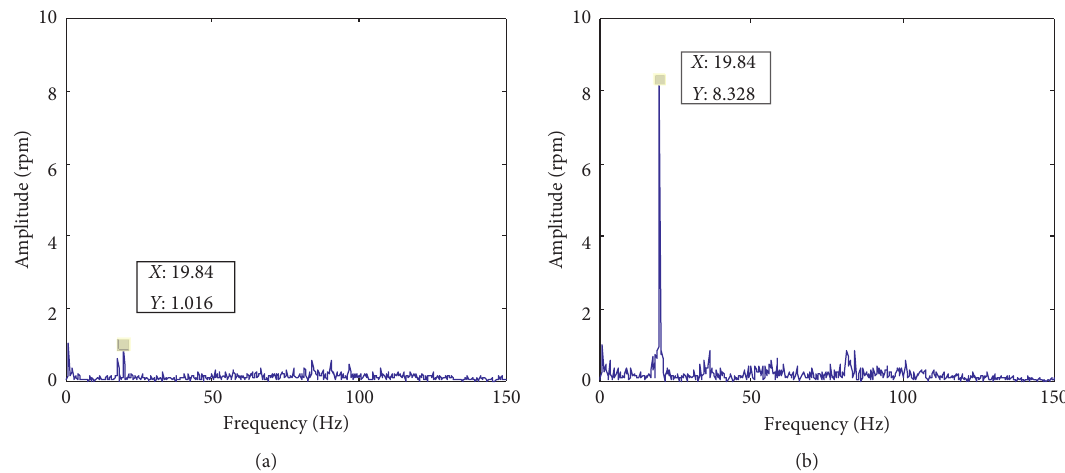
Figure 22: Spectrums of the transient torsional motions at t ∈ [ 1s , 1 . 2s ] (steady flight) and at t ∈ [ 2 . 5 s , 2 . 7s ] (maneuvering flight). (a) t ∈ [ 1s , 1 . 2s ] and (b) t ∈ [ 2 . 5 s , 2 . 7s ]